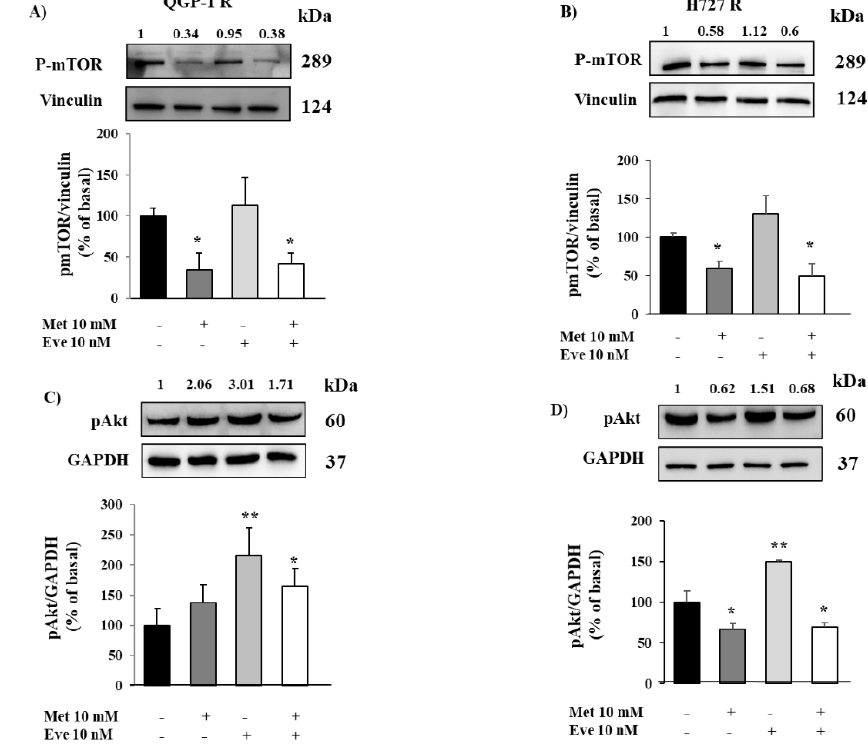
Figure 7. The e ff ect of metformin (Met) on mTOR and Akt phosphorylation in QGP-1-R and H727-R cells. ( A , B ) Representative immunoblots of phospho-mTOR demonstrating that metformin continued to inhibit mTOR phosphorylation in everolimus-resistant QGP-1-R and H727-R cells. Graphs show the quantification of phospho-mTOR normalized to the housekeeping gene vinculin (mean value ± SD from 3 independent experiments). * = p < 0.05 vs. corresponding basal. Statistical analysis was performed with a one-way ANOVA test followed by Dunnett’s post-hoc test. ( C , D ) Representative immunoblots of p-Akt, after metformin and everolimus incubation, alone or in combination. Metformin did not a ff ect Akt phosphorylation in QGP-1-R cells, conversely, significantly decreased p-Akt in H727-R cells. Graphs show the ratio of p-Akt / GAPDH normalized to basal (mean value ± SD from 3 independent experiments). * = p < 0.05, ** = p < 0.01 vs. corresponding basal. Statistical analysis was performed with a one-way ANOVA test followed by Dunnett’s post-hoc test. Unprocessed images for WB results see Figures S4 and